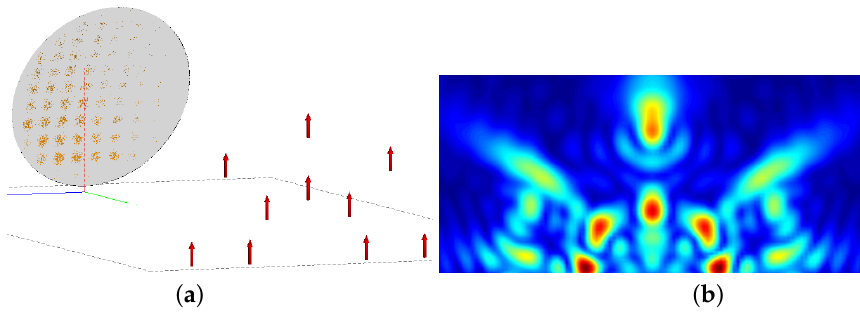
Figure 7. ( a ) Simulation of 10 dipole sources (4 GHz,1 V/m); ( b ) resulting image.